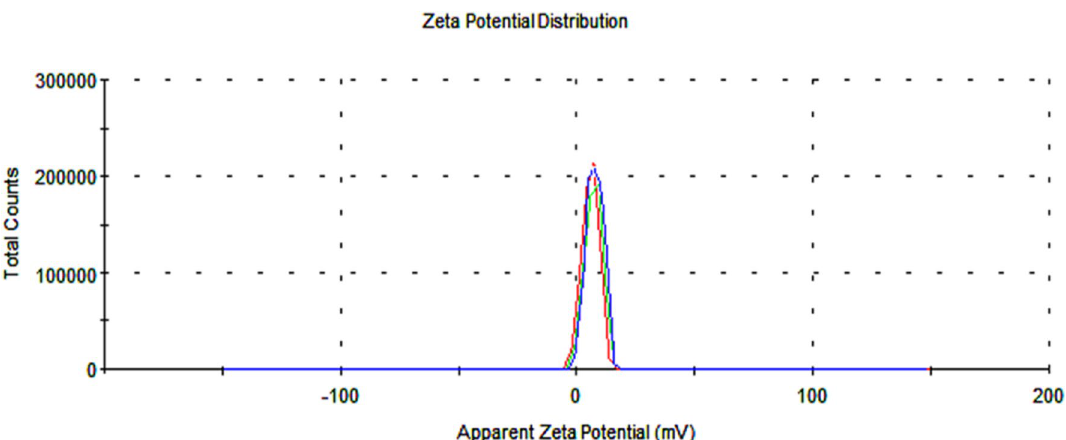
Fig. 8 Zeta potential analysis of zinc oxide NPs